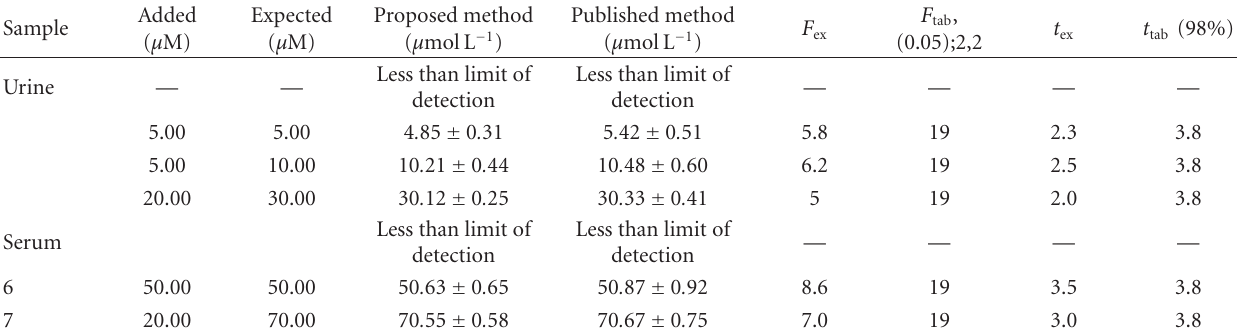
Table 4: Concentration values obtained from the proposed and published methods for Hcy analysis in real samples. Sample